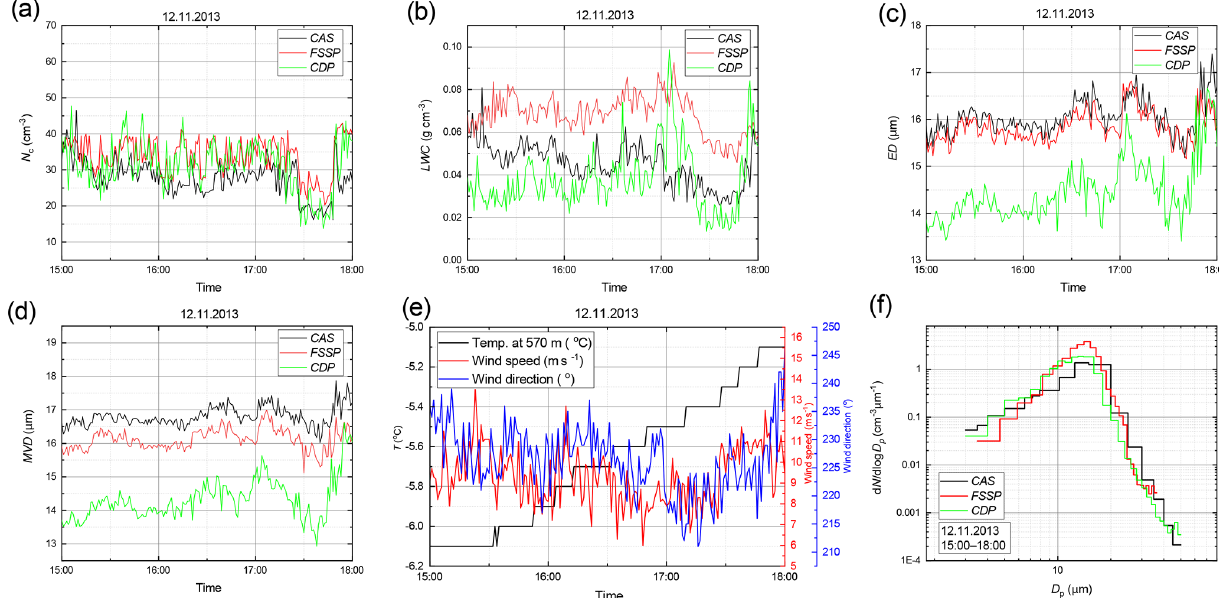
Figure 6. Time series on 25 October from 12:00 to 15:00. The main parameters as they were derived/measured from all three cloud probes: (a) N c ; (b) LWC; (c) ED; (d) MVD; (e) temperature, wind speed, wind direction; and (f) size distribution. During this case the probes were not facing in the same direction. Agreement in N c between CAS and CDP indicates that the CDP rotation system was frozen and CAS was not facing the wind. Large discrepancies were observed in LWC and slight discrepancies in ED and MVD. The main reason for these discrepancies was the different sizing ability of the